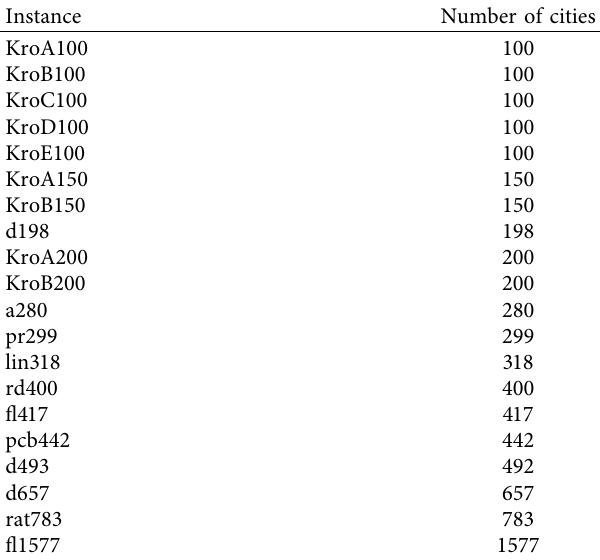
Table 2: Description of the